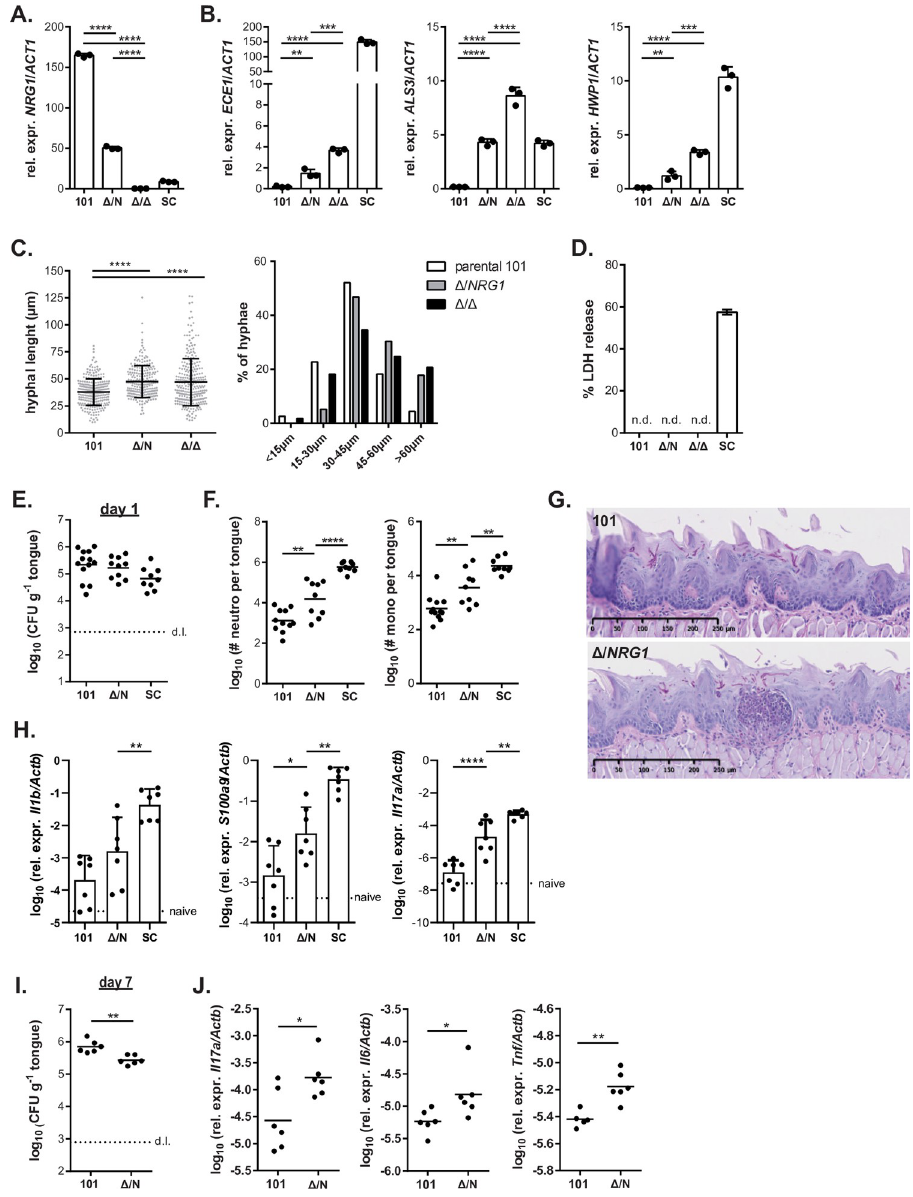
Fig 6. Reduced expression of NRG1 in isolate 101 increases its pathogenicity. A.-D. Monolayers of TR146 keratinocytes were infected with isolates 101 nrg1 Δ / NRG1 , 101 nrg1 Δ / Δ , the parental isolate 101 and strain SC5314. Expression of the indicated fungal genes was assessed by RT-qPCR after 24 hours of infection ( A, B) . Bars are the mean+SD of 3 samples per condition. Data are representative of 2 independent experiments. Filamentation was assessed after 3.5 hours of infection by measuring the length of individual filaments ( C , left). Each dot represents an independent hyphal element; the mean ± SD is indicated. Fungal elements were grouped according to their length and the proportion of fungal elements in each group is shown ( C , right). Data are representative of 3 independent experiments (only one experiment for 101 nrg1 Δ / Δ ). Epithelial cell damage was assessed by LDH release assay at 24 hours post-infection ( D ). Bars are the mean+SEM of 10–22 samples per group pooled from 2–3 independent experiments. E.-J. C57BL/6 WT mice were infected sublingually with isolates 101 nrg1 Δ / NRG1 , the parental isolate 101 and SC5314. Fungal burden was assessed after 1 day ( E ) or 7 days of infection ( I ). Neutrophils and monocytes in the tongue were quantified by flow cytometry ( F ) and tongue sections were stained with PAS ( G ) on day 1 post-infection. The indicated host transcripts in the tongue were quantified by RT-qPCR on day 1 ( H ) or day 7 post-infection ( J ). In E, F, H, I and J, each symbol represents one animal; the mean is indicated. Data in E, F, H, I and J are pooled from 2–3 independent experiments. Please see also S5 Fig